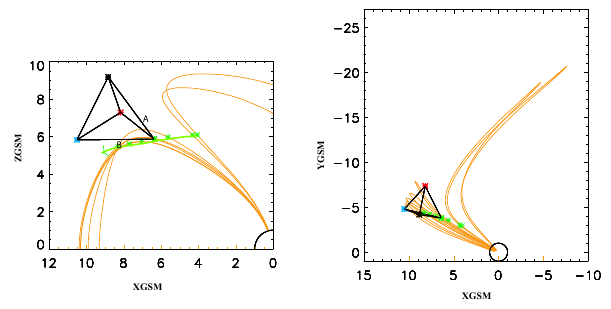
Fig. 1. The trajectory and the configuration of the Cluster quartet during the event with regard to the magnetic fields in X GSM − Z GSM and X GSM − Y GSM planes. The magnetic field lines are derived from the T96 model using the solar wind and IMF conditions at the time. The green asterisks along the trajectory are the spacecraft position at 00:00, 00:10, 01:00, 01:30, 02:00, 02:30 and 03:00 UT, respectively. Also shown in Fig. 1 is the tetrahedron made up by the four spacecraft at 01:30 UT (for the purpose of clar- ity, the separation distance relative to C3 was multiplied by a factor of 5.0) with C1 in black, C2 in red, C3 in green and C4 in blue.